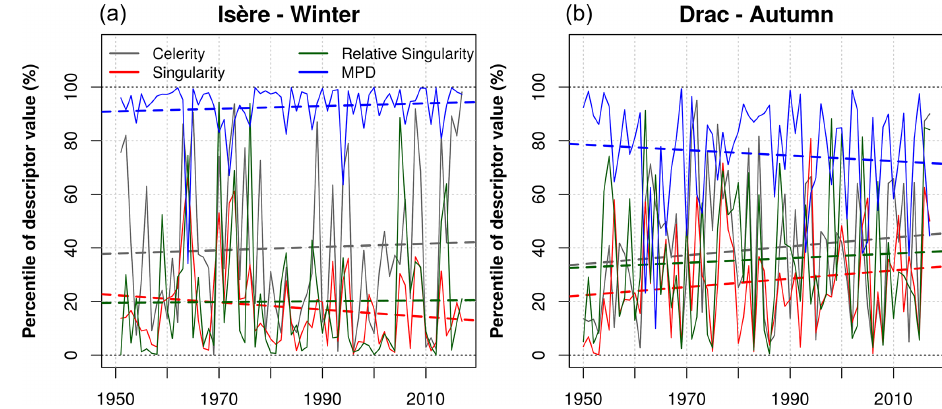
Figure 13. Evolution of descriptor percentiles at the date of the seasonal maxima of daily precipitation for the Isère River catchment in winter (a) and the Drac River catchment in autumn (b) over the period 1950–2017. Percentiles are computed with respect to all days of the period 1950–2017. Non-significant trends are represented by dotted lines. The trend is considered as significant if the p value of the Student test is lower than